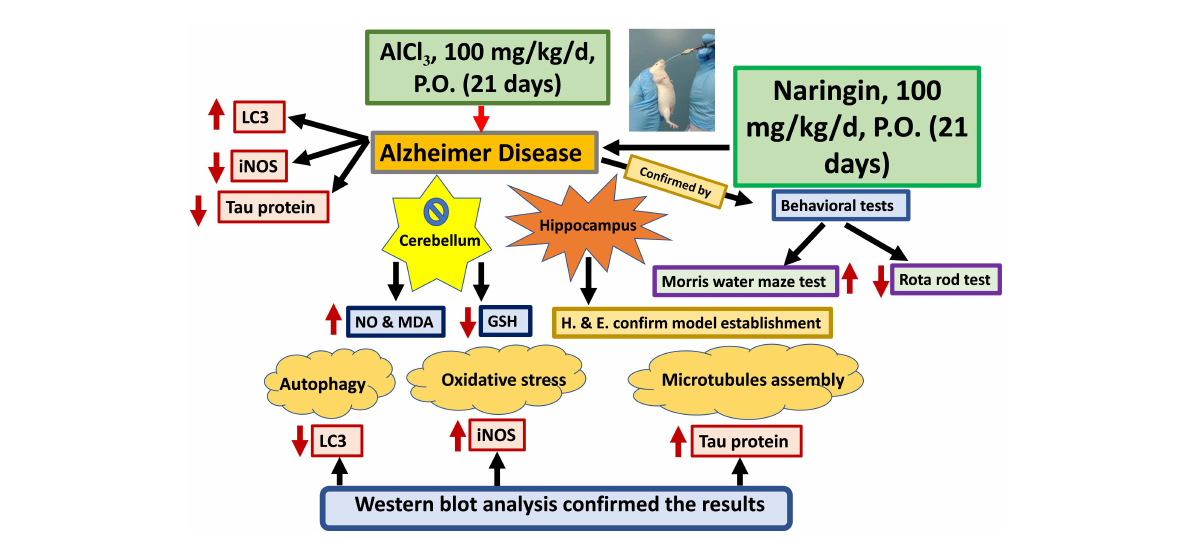
FIGURE11 Graphical abstract. Naringin improves the cerebellar neurotoxicity induced by AlCl 3 evaluated by decrease of the oxidative stress marker (in the form of decreasing the iNOS); decrease the microtubule assembly marker (Tau protein) and increase the autophagy marker (LC3). AlCl 3 , Aluminum chloride; Inos, Inducible nitric oxide synthase; LC3, Light chain 3; GSH, Reduced glutathione; NO, Nitric oxide and MDA,